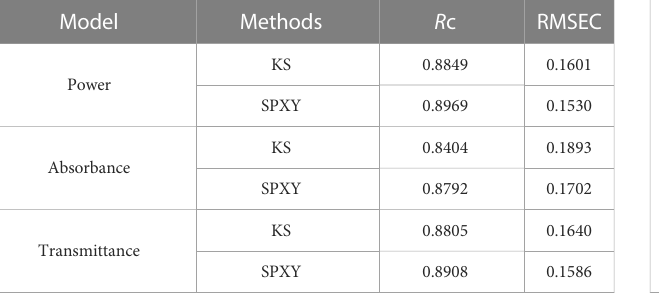
TABLE 2 Modeling results after classi fi cation by the KS and SPXY algorithms. Model